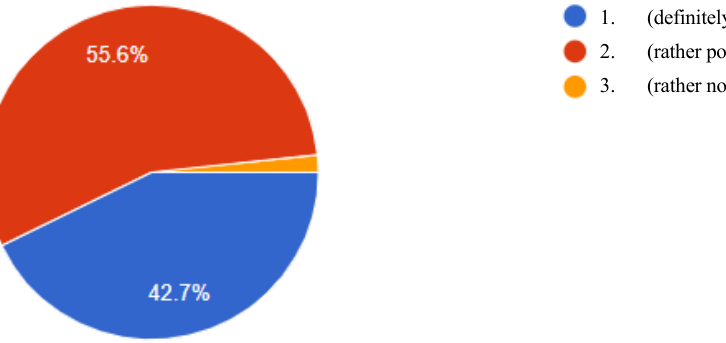
Figure 1. The distribution of the answers about the possibility of replacing conventional energy sources.